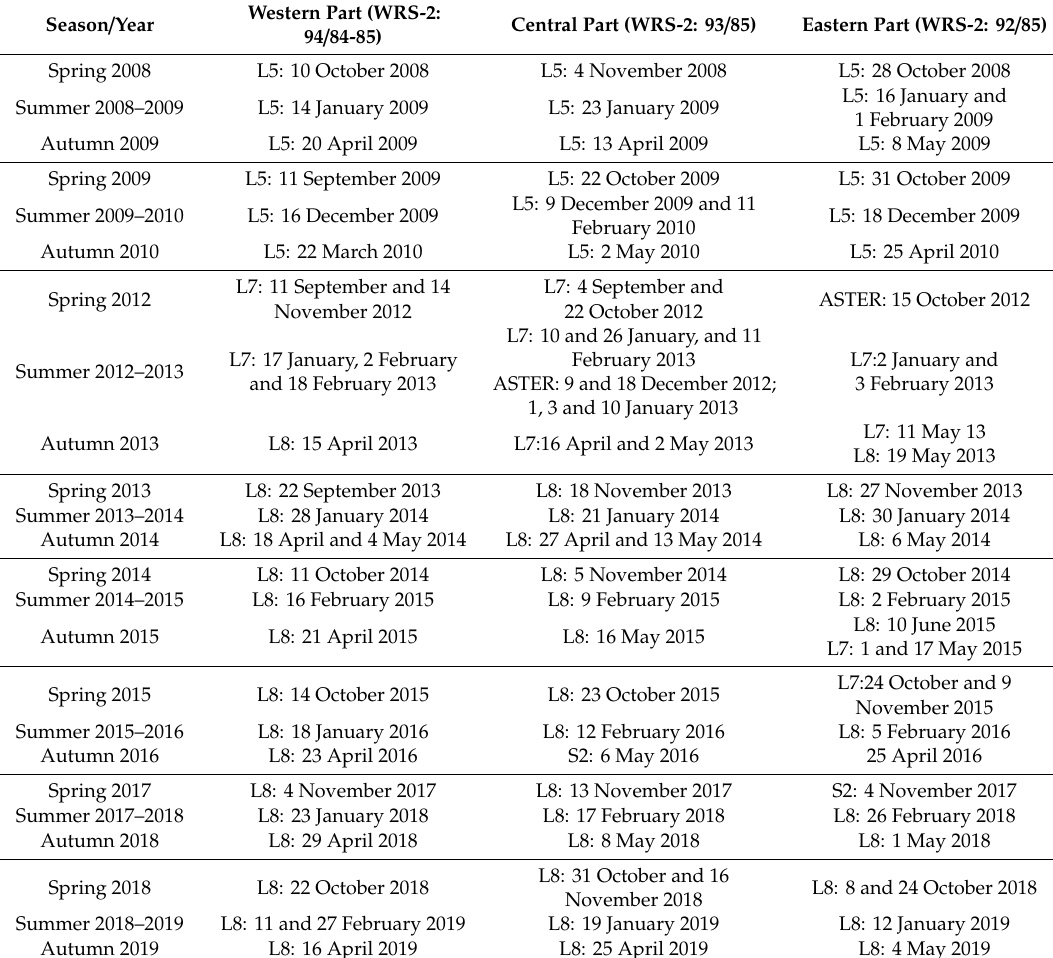
Table 1. List of satellite images